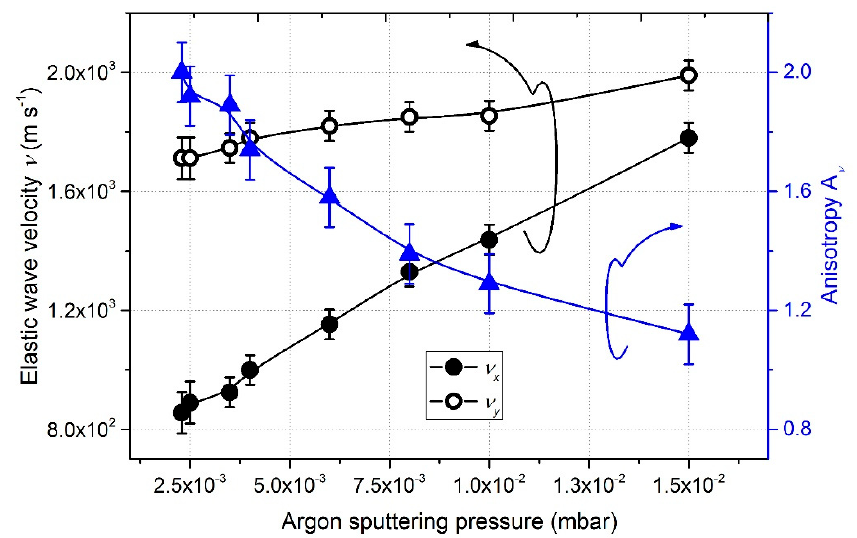
Figure 9. Group velocities of pseudo-Rayleigh waves along x and y -axes and related anisotropic coefficient as a function of the argon sputtering pressure. Table 2. Calculated porosity as a function of the argon sputtering